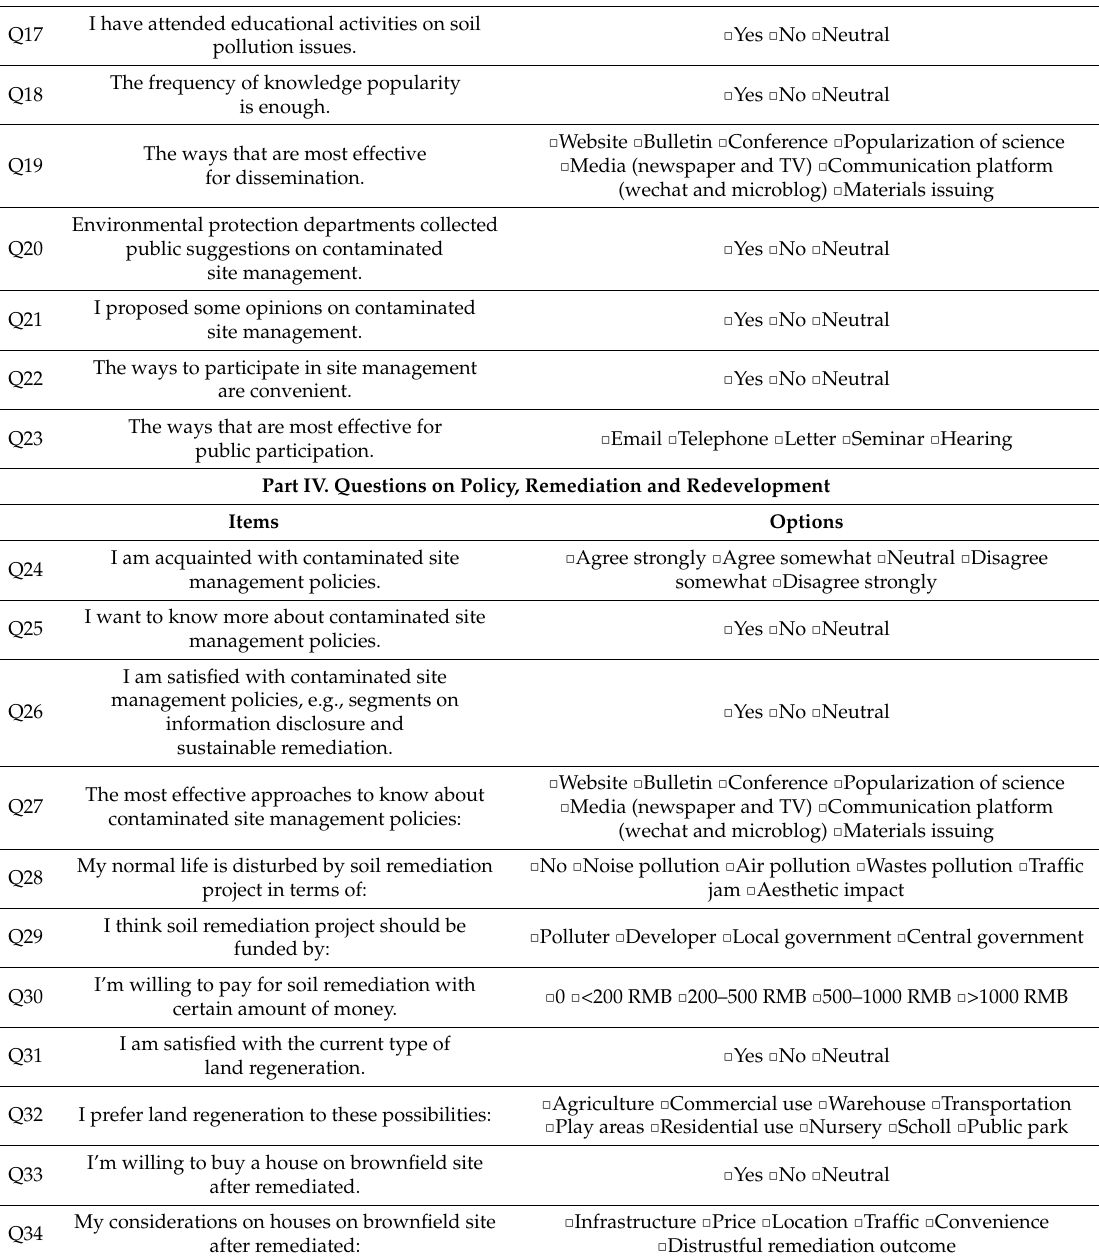
Part III. Questions on Execution Capability of Local